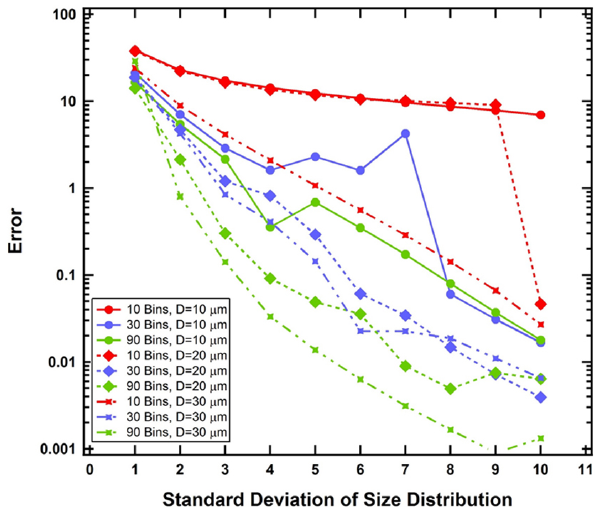
Figure 9. The sets of curves shown in this figure illustrate the accu- racy of the inversion as a function of the standard deviation of the simulated actual (Gaussian) size distribution. Each color represents a simulated, measured size distribution binned in 10 channels (red), 30 (blue) and 90 (green). The average diameter of the simulated ac- tual distribution is varied from 10µm (solid curves), 20µm (dashed) and 30µm